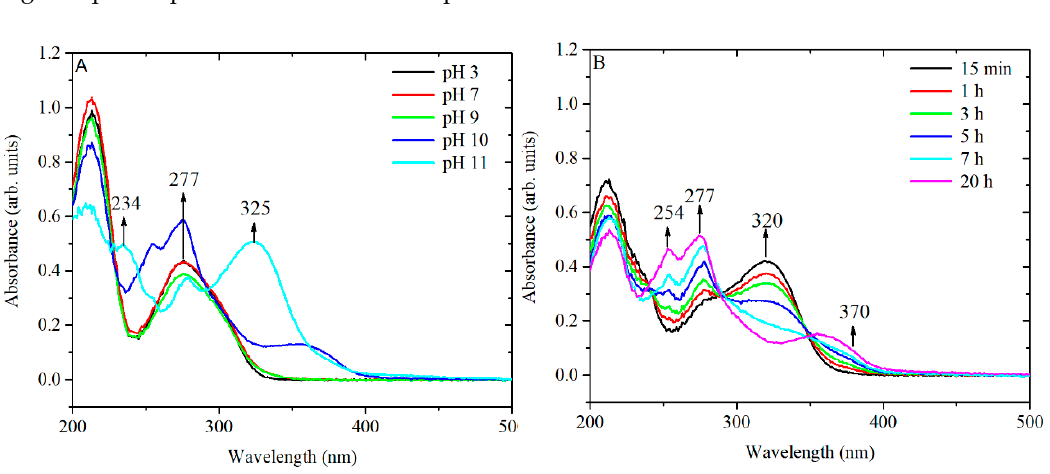
Figure 8. ( A ) UV-vis spectra of TA solutions equilibrated for 24 h at various values of pH and ( B ) temporal variation of the UV-vis spectra of TA at pH 10 at room temperature (RT).